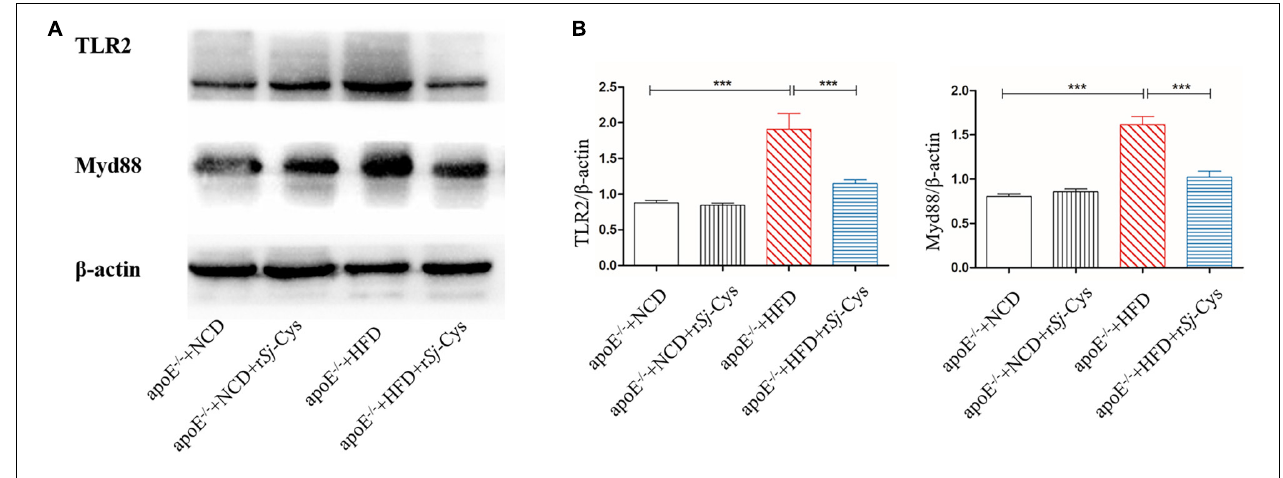
FIGURE 10 | r Sj -Cys reduced the expression of TLR2, MyD88 in the kidneys of mice detected by Western blot (A) . The β -actin was measured as control. The density ratios of TLR2/ β -actin and MyD88/ β -actin are shown on the right (B) . The results are shown as the density mean ± SEM for each group ( n = 6). *** P <